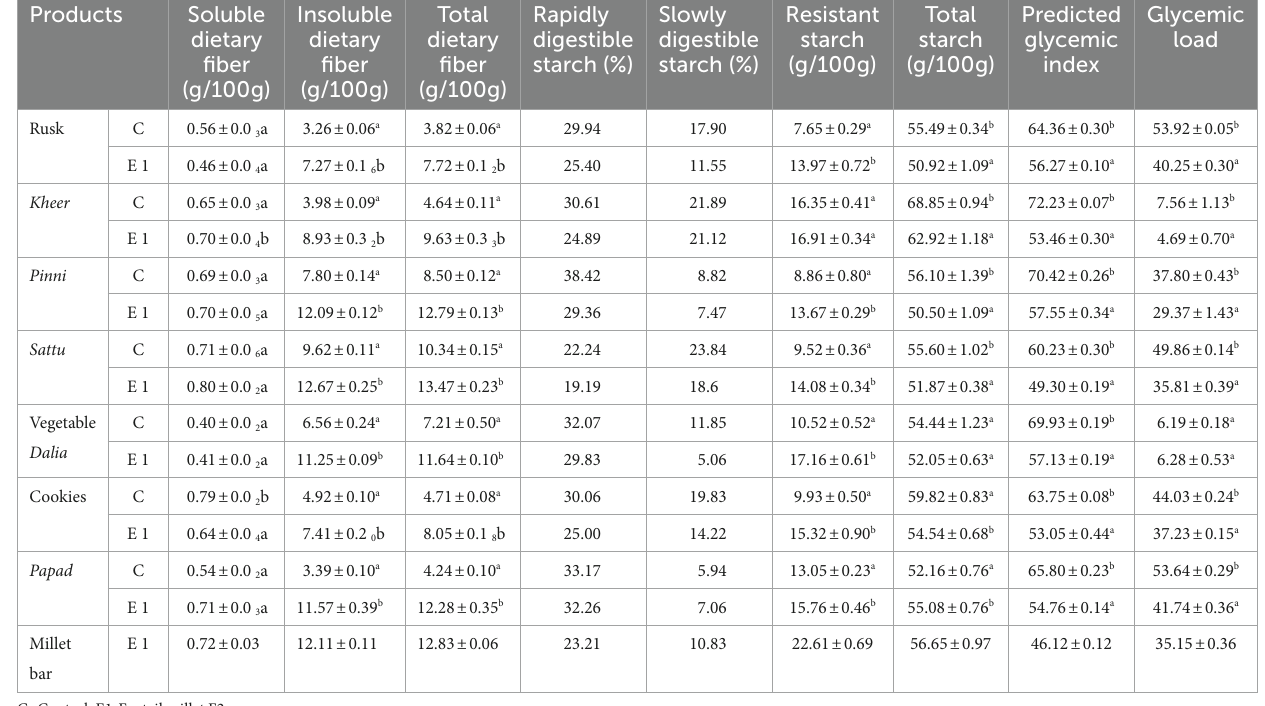
TABLE 4B Nutritional composition of the value added products.